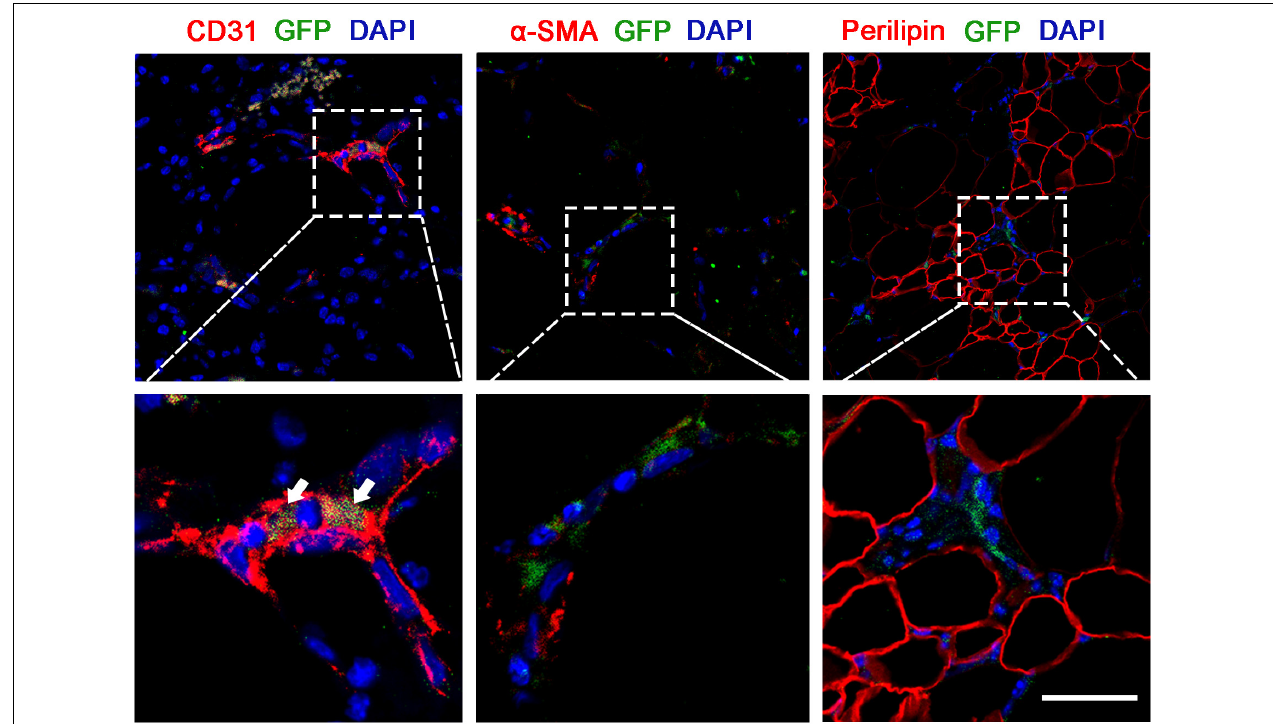
FIGURE 5 | ASCs in Crdf differentiate into vascular endothelium. GFP fluorescence in conjunction with CD31, α SMA, and perilipin immunofluorescence were applied to identify the transformation of supplemented GFP + ASCs. Scale bar = 50 µ